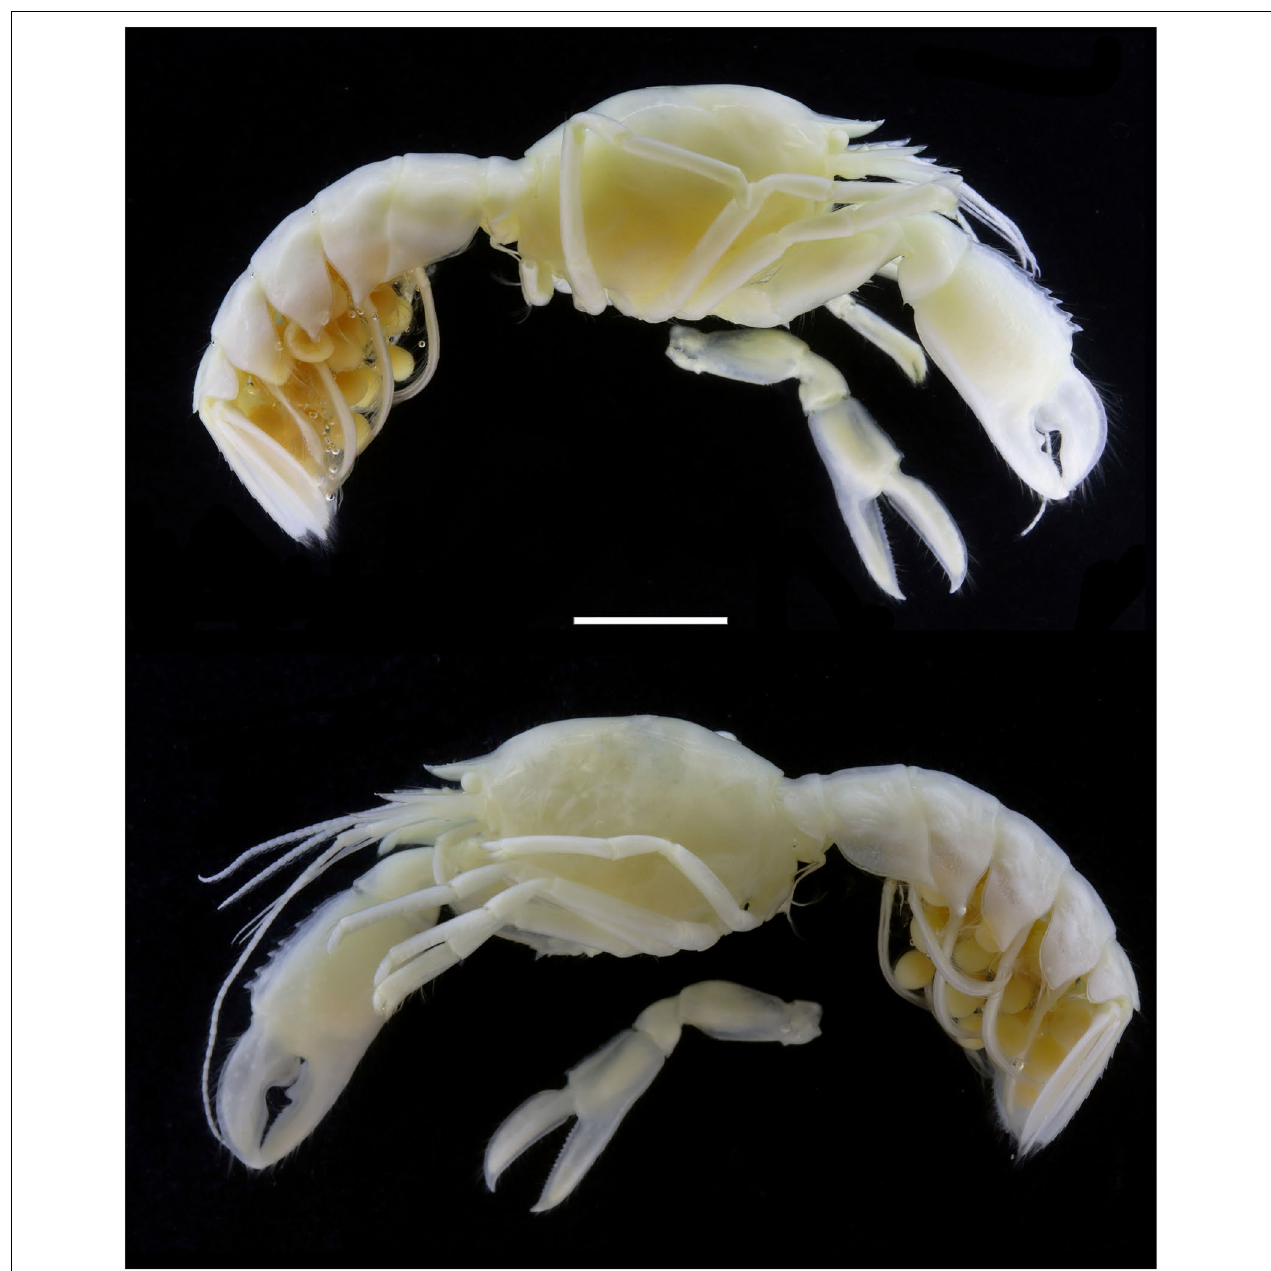
FIGURE 1 | Eiconaxius serratus sp. nov . Holotype, SRSIO 14070301 (ovigerous female, cl 9.0 mm). Scale: 5 mm.